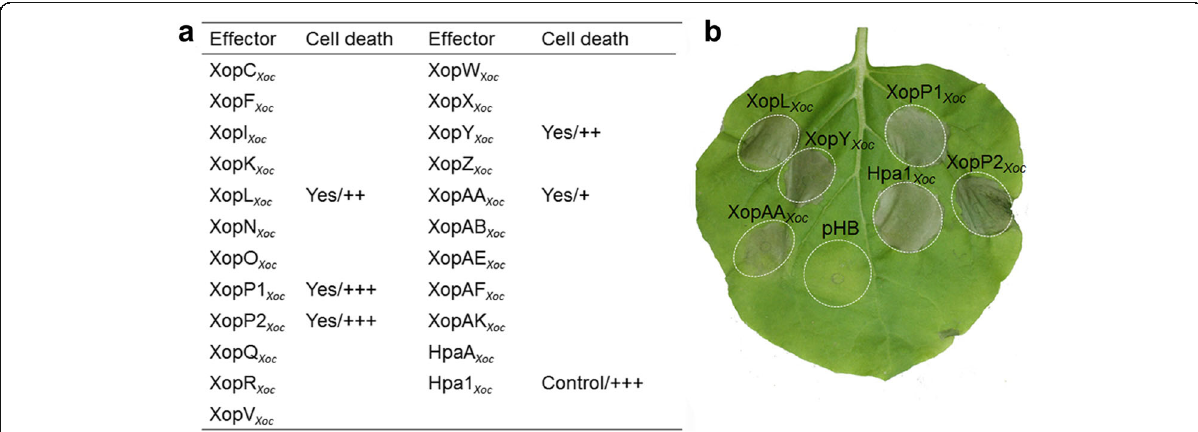
Fig. 1 Cell death responses induced by T3Es of X. oryzae pv. oryzicola RS105. a The predicted T3Es and their abilities to trigger cell death in Nb . T3Es were transiently expressed in tobacco leaves mediated by Agrobacterium . Harpin protein Hpa1 was used as positive cell death inducer. +++, ++, and + indicate cell death appeared at 4, 7, and 10 dpi, respectively. b Cell death phenotypes induced by effectors. Picture was taken at 10